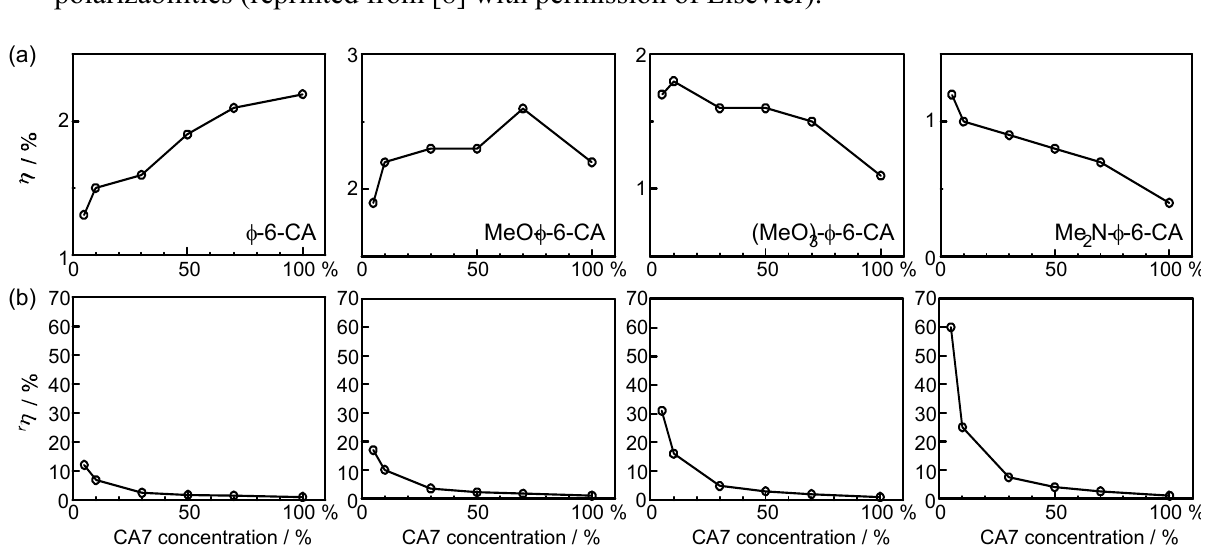
Figure 14. Concentration dependence of ( a ) the conversion efficiency ( η ) and ( b ) the relative conversion efficiency ( r η ) in solar cells using the four sensitizers with increasing polarizabilities (reprinted from [8] with permission of